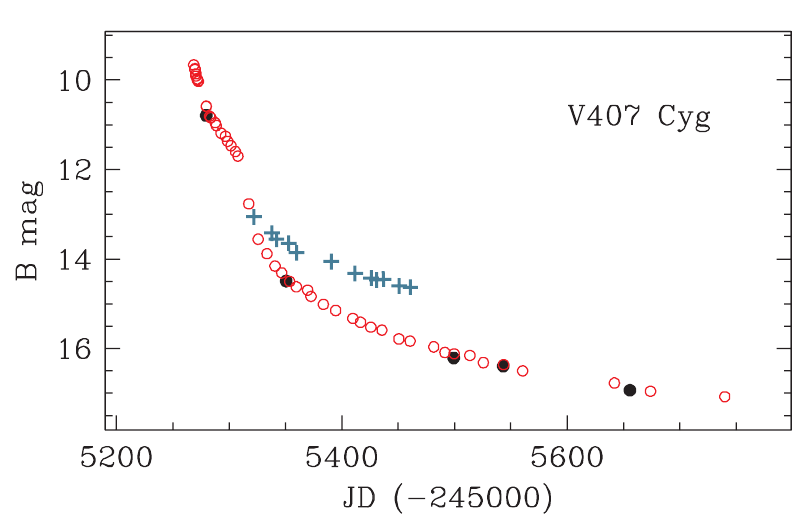
Fig. 8. The effect of the red leak of multi-layer filters when observing very red stars, like V407 Cyg during the return to quiescence following its 2010 outburst. Magnitudes B from the ANS telescope R061 (crosses), equipped with Astrodon filters, deviated from those of the telescopes equipped with classical colored glass filters (open and filled circles) when V – I C turned (cid:21) 3.8.